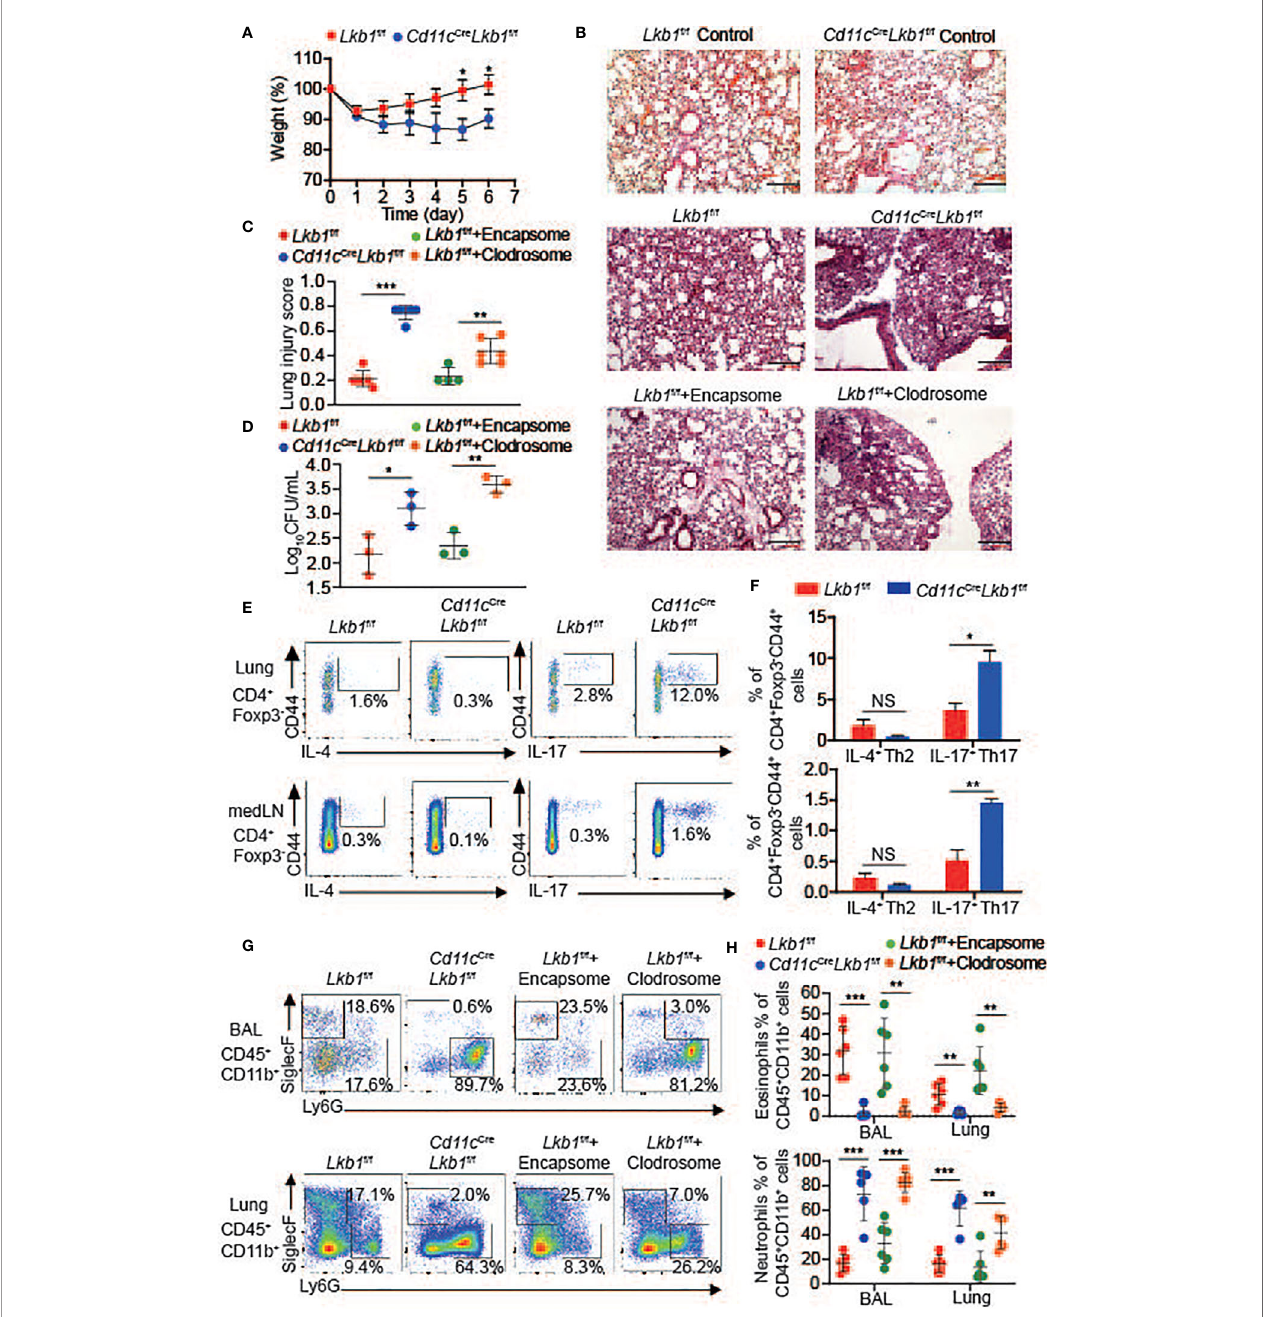
FIGURE 3 | Cd11c Cre Lkb1 f/f mice are more susceptible to S. aureus infection. (A) The relative weights of Lkb1 f/f and Cd11c Cre Lkb1 f/f mice challenged with S. aureus intranasally (n = 9 – 11). (B) Images show histopathological sections of lungs from naive Lkb1 f/f mice, Cd11c Cre Lkb1 f/f mice, and Lkb1 f/f , Cd11c Cre Lkb1 f/f and Lkb1 f/f mice intranasally administered Encapsome or Clodrosome, intranasally challenged with S. aureus , and stained with hematoxylin and eosin (scale bar, 100 m m). (C) The lung injury score was evaluated blindly by two independent investigators (n = 6). (D) Quanti fi cation of BAL fl uid CFUs cultured for 48 h from Lkb1 f/f , Cd11c Cre Lkb1 f/f and Lkb1 f/f mice intranasally administered Clodrosome or Encapsome and intranasally challenged with S. aureus . (E, F) Flow cytometry analysis (E) and the frequencies (F) of CD4 + Foxp3 − CD44 + IL-4 + Th2 cells or CD4 + Foxp3 − CD44 + IL-17 + Th17 cells in the lung and medLNs from Lkb1 f/f and Cd11c Cre Lkb1 f/f mice challenged with S. aureus intranasally (n = 3). (G, H) Flow cytometry analysis (G) and quanti fi cation of the percentages (H) of eosinophils (CD45 + CD11b + Siglec-F + ) and neutrophils (CD45 + CD11b + Ly6G + ) in BAL fl uid and lungs from Lkb1 f/f , Cd11c Cre Lkb1 f/f and Lkb1 f/f mice intranasally administered Encapsome or Clodrosome and challenged with S. aureus intranasally (n = 3). Each symbol (C, D, H) represents a mouse, and the results are presented as the mean ± S.D., NS (not signi fi cant) P > 0.05, * P < 0.05, ** P < 0.01, *** P < 0.001 (by Student ’ s t -test) (C, D, F, H) , two-way ANOVA (A) . All data represent at least two to three independent